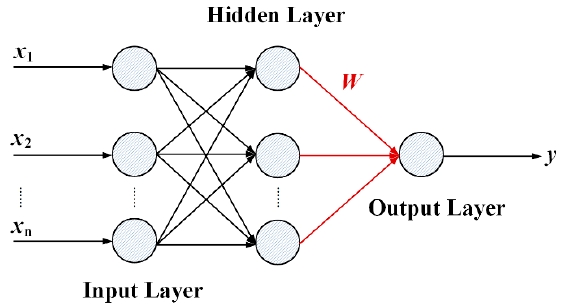
Figure 8. The structure of the RBF surrogate model [34].